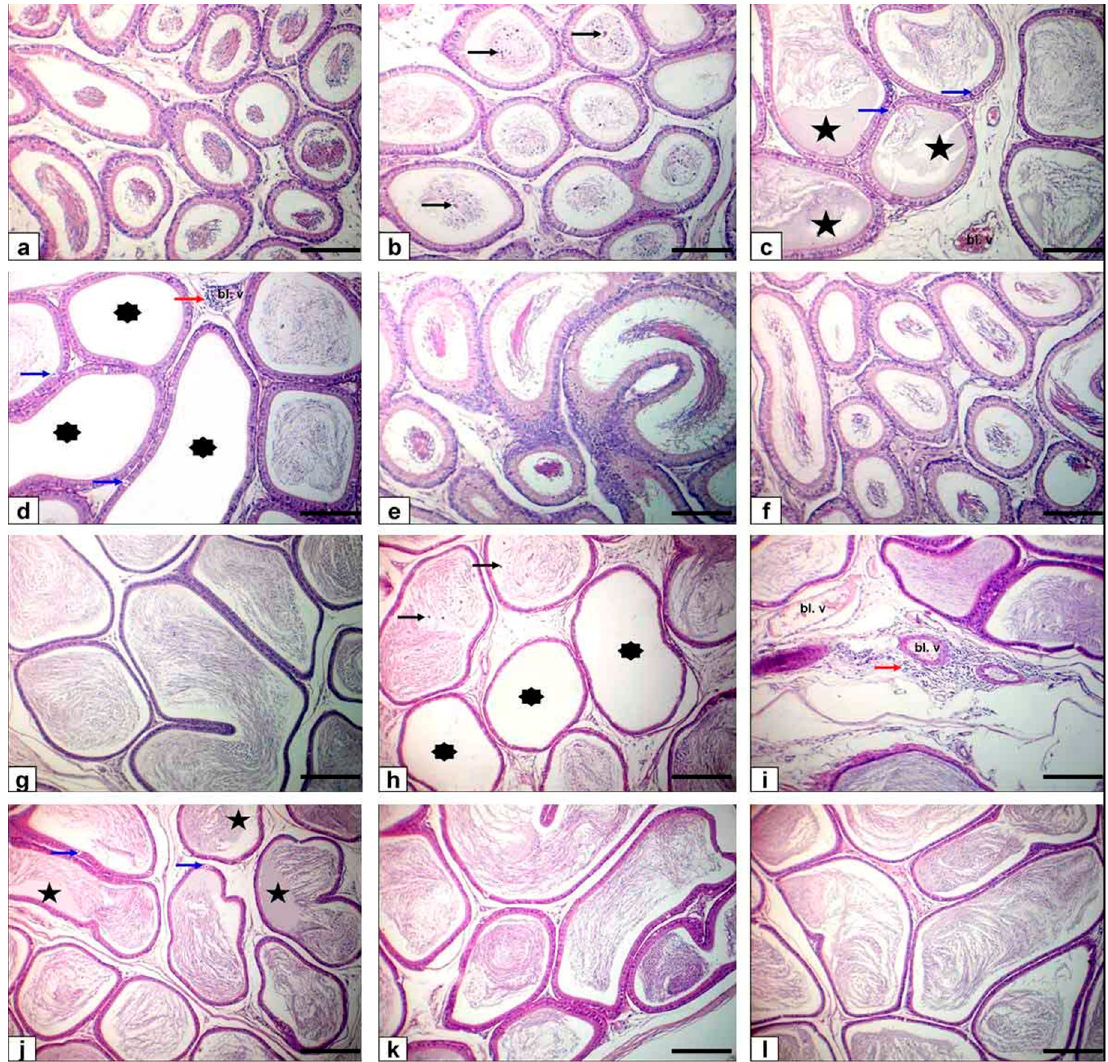
Figure 3. Photomicrograph of rat epididymis stained with HE. Bar = 100 µm. ( a – f ) Caput epididymis ( g – l ) cauda epididymis. ( a , g ) Normal histological structure with normal sperm density of control rats. ( b – d , h – j ) FPN-treated rats showing sloughing of some germinal epithelial cells (black arrows), vacuolation of few germinal epithelial cells (blue arrows), interstitial congestion of blood vessel (Bl. v) with interstitial and perivascular inflammatory cell infiltrations (red arrow) in addition to low or/and free (asterisks) sperm density with hyalinization of the luminal contents (stars) of some ductal epididymis. ( e , k ) FPN + BA 1 rats showing normal structure with the marked enhancement of sperm density. ( f , l ) FPN + BA 2 rats showing normal structural integrity and sperm density.